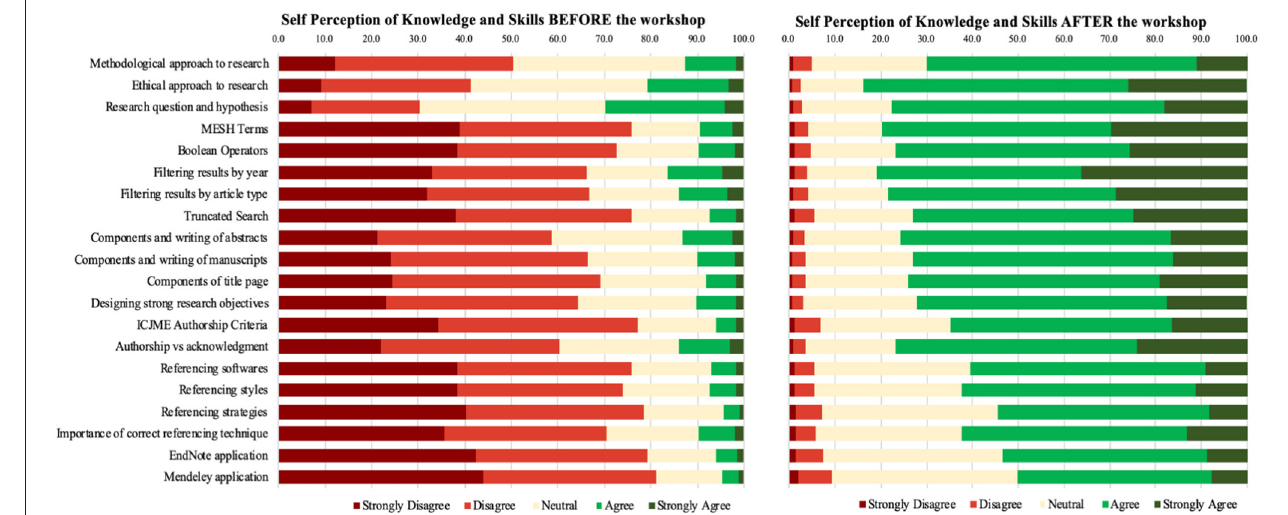
FIGURE 3 | Subjective assessment: categorical assortment of participants’ self-perceptions.